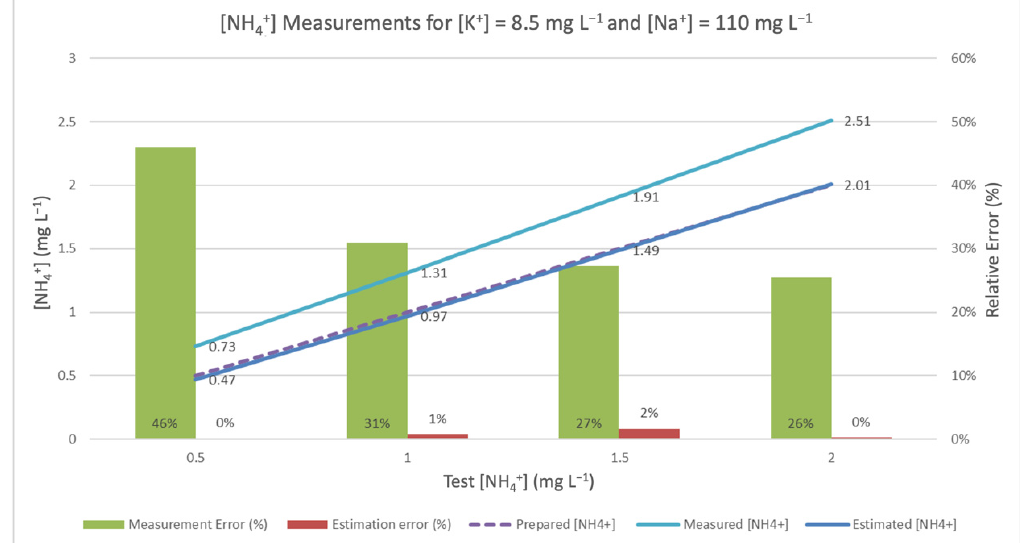
Figure 4. Measured and corrected [NH 4 + ] in the presence of [K + ] = 8.5 mg L − 1 and [Na + ] = 110 mg L − 1 .